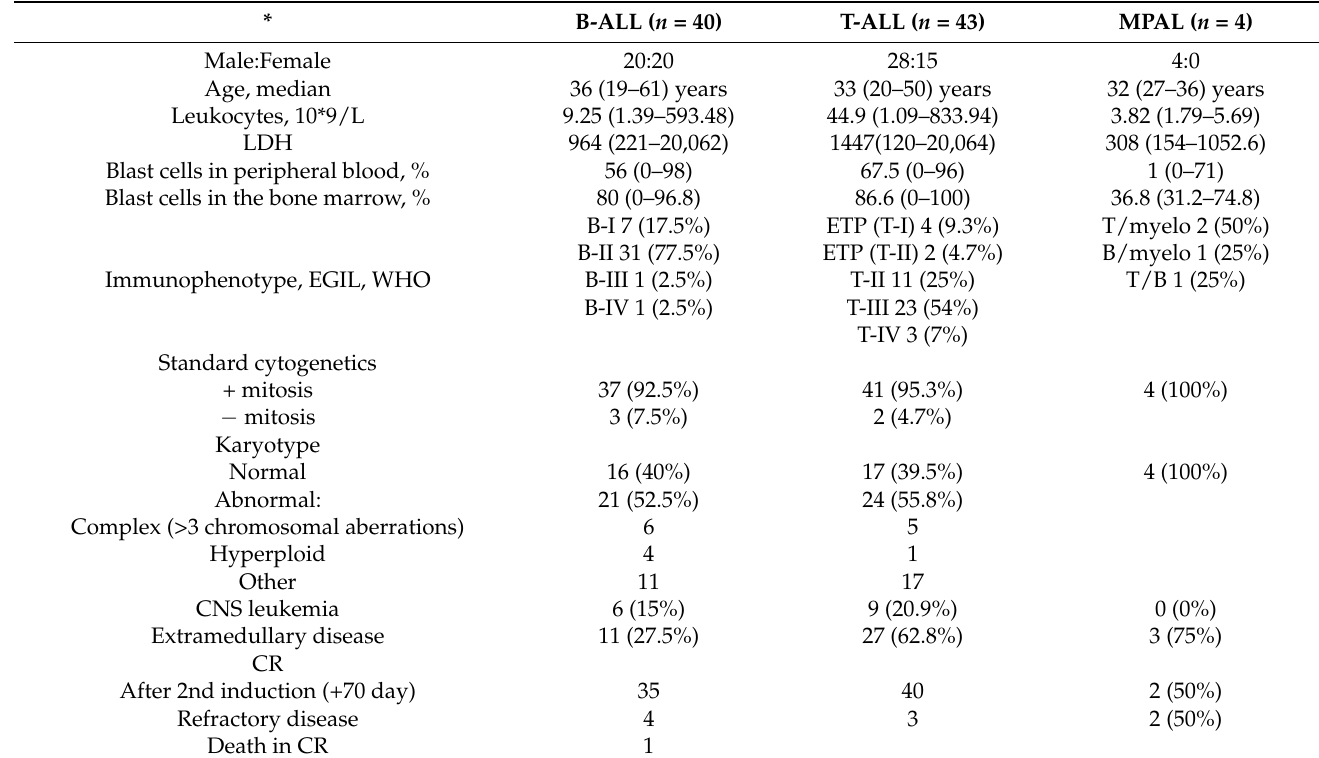
Table 1. The main characteristics of the